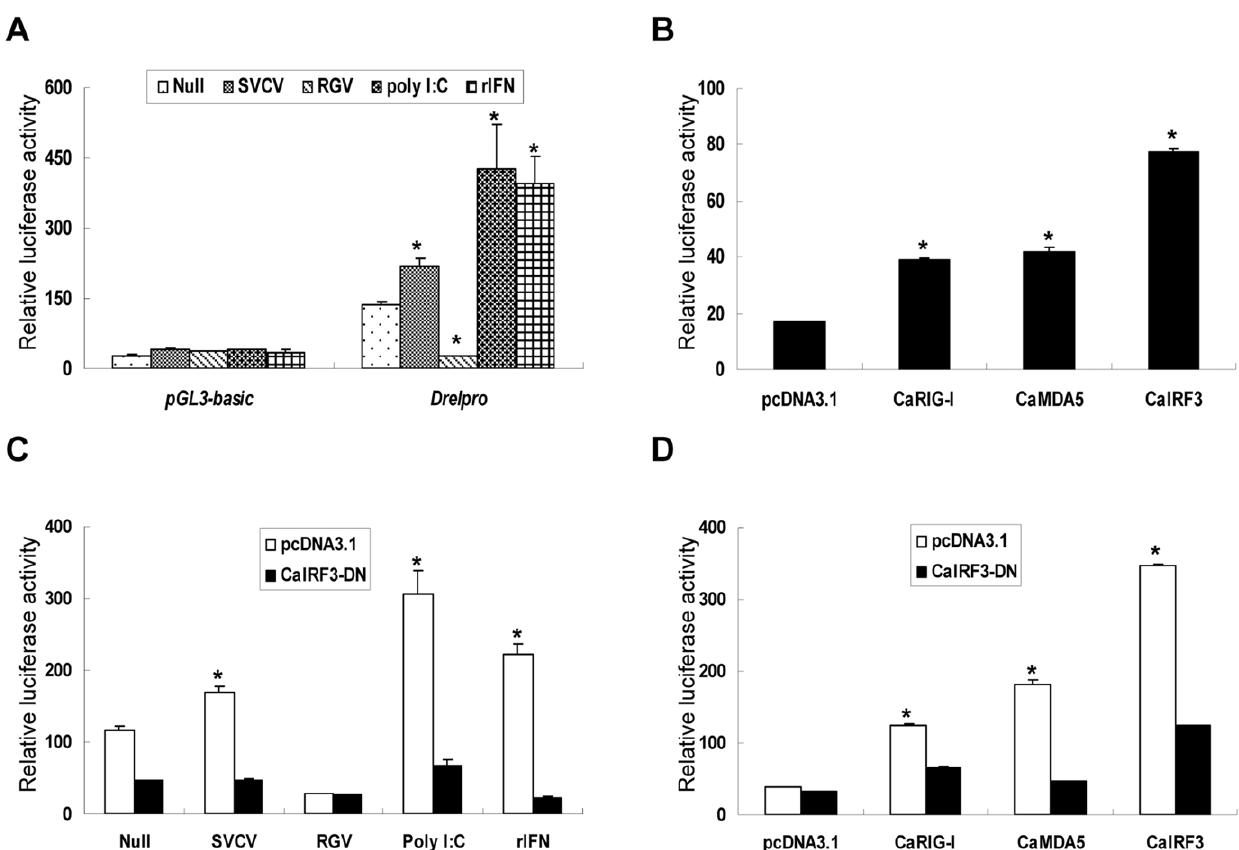
Figure 4. Activation of DreI promoter by several stimuli via RLR signaling. (A) Induction of DreI promoter by SVCV, RGV, rIFN and poly I:C for 24 h. EPC cells seeded in 24-well plates overnight were transfected with DreI pro-Luc, and pRL-TK was used as an internal control. At 24 h after transfection, cells were treated with several stimuli or left untreated. The luciferase activities were monitored at 24 h after stimulation. (B) EPC cells were cotransfected with pcDNA- CaRIG-I , pcDNA- CaMDA5 , or pcDNA- CaIRF3 and DreI pro-Luc at the ratio of 1:1. The luciferase activity was assessed at 48 h post-transfection. (C) EPC cells were cotransfected with DreI pro-Luc and pcDNA- CaIRF3-DN and stimulated with several stimuli at 24 h posttansfection. Luciferase activities were monitored at 24 h after stimulation. (D) EPC cells were cotransfected with pcDNA- CaRIG-I , pcDNA- CaMDA5 , or pcDNA- CaIRF3 and DreI pro-Luc plus pcDNA- IRF3-DN at the ratio of 1:1:1. At 48 h posttransfection, cells were collected for detection of luciferase activates. The results represent three independent experiments and error bars are the SDs obtained by measuring each sample in triplicate. The significant differences between control and treatments groups are determined by T-TEST. *p , 0.01.